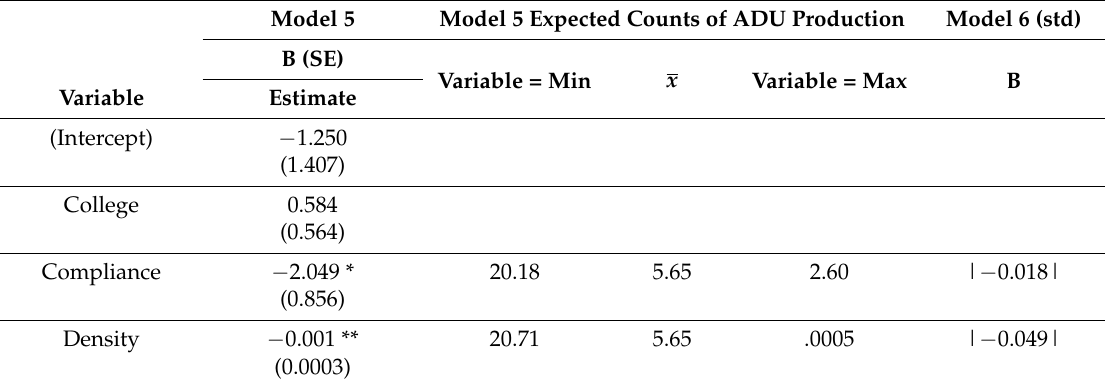
Table 10. The negative binomial regression models. Model 5 includes potential ADUs and contains the full sample. Model 5 indicates that cities could expect roughly four ADUs when their count of potential ADUs is zero, six ADUs when their count of potential ADUs is near the mean, and roughly 26 ADUs when the count of potential ADUs is near the maximum value of 72. Model 6 (std) contains the standardized coefficients of Model 5. Of the four statistically significant variables, Density and Renters maintained equal influence due to their respective absolute values. Notes: ADU = accessory dwelling unit, SE = standard error, STD = standardized; * = p < 0.05, ** = p < 0.01, *** = p <